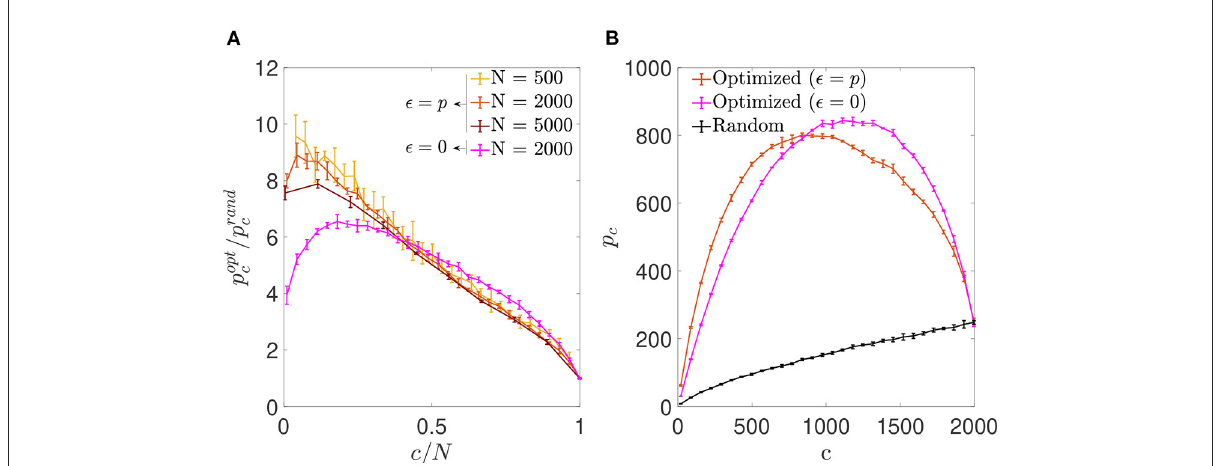
FIGURE5 Signal reinforcement outperforms noise reduction and is optimal with highly diluted connectivity. (A) Ratio between the storage capacity for optimized ( p opt c ) and random ( p rand c ) connectivity as a function of the number of connections per neuron for networks of different N (shades of red; mean ± s.d.). For comparison, the curve corresponding to noise reduction is included (magenta; N = 2,000). (B) Overall maximum number of patterns (not normalized by c ) that can be stored and retrieved as a function of c in a network with N = 2,000 optimized by signal reinforcement (orange), optimized by noise reduction (magenta) or with random connectivity (black) (mean ± s.d.). Note that, as in Figure 1, the maxima for p opt c / p rand c (A) and p opt c (B) occur for different connectivity levels. Pool of data corresponding to five simulations for each